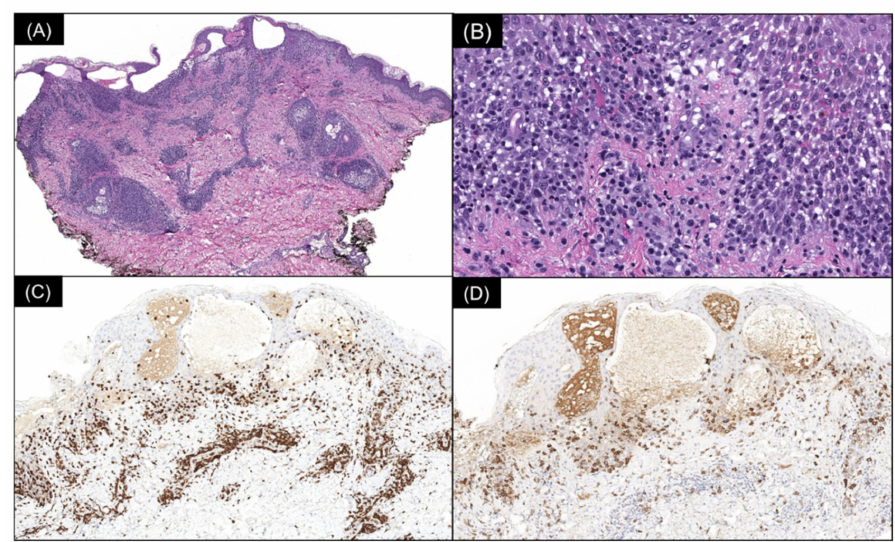
Figure 3. ( A ) Spongiotic vesiculation, reticular degeneration, and a wedge-shaped, moderately dense superficial perivascular lymphocytic infiltrate (H & E, 40 × ). ( B ) Higher power demonstrates basal layer vacuolization, lymphocytic exocytosis, and extravasated red blood cells (H & E, 200 × ). ( C ) Immunoperoxidase staining reveals the lymphocytic infiltrate to be composed of CD3 (+) T cells (80 × ) with ( D ) an intraepidermal population staining with CD30 (80 × ).